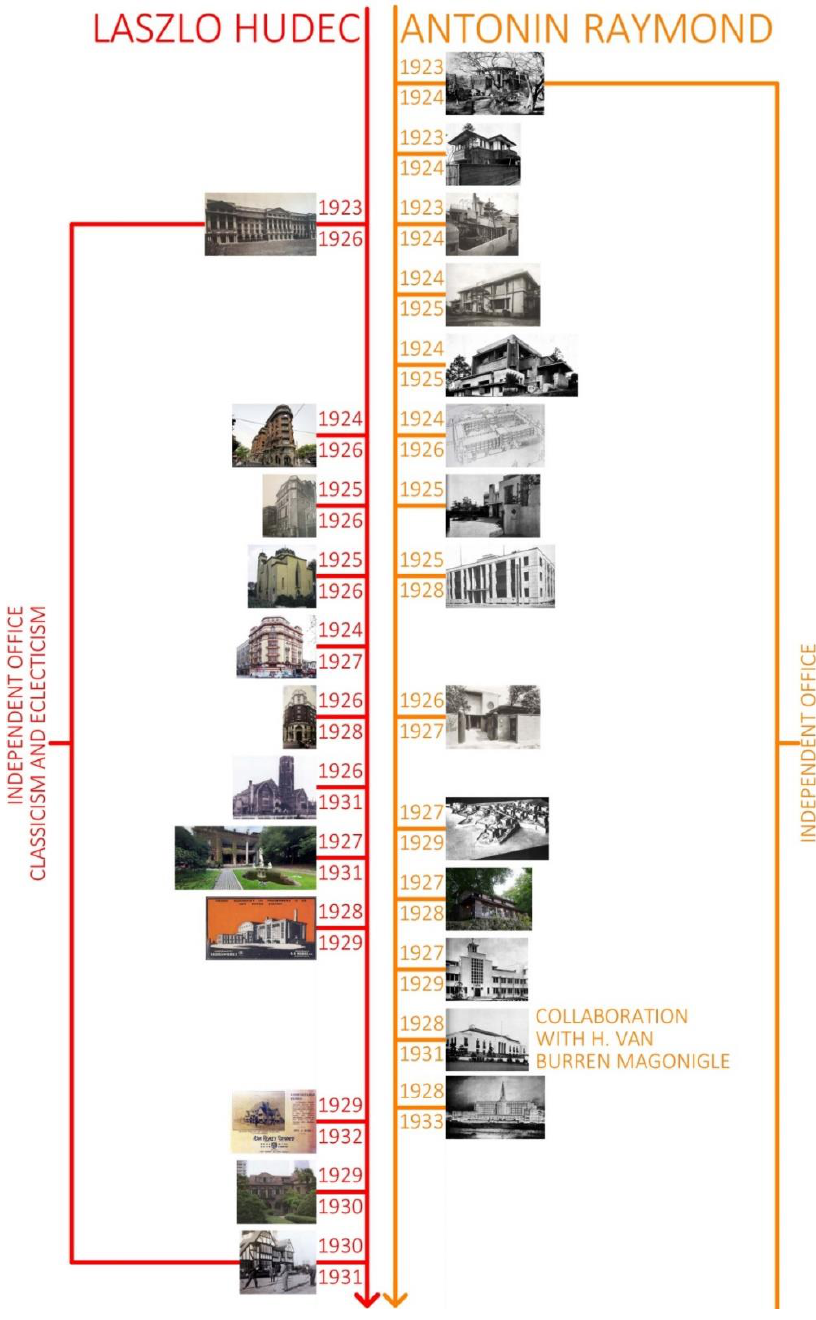
Figure 3. Timeline 02 — Hudec and Raymond comparative designs.